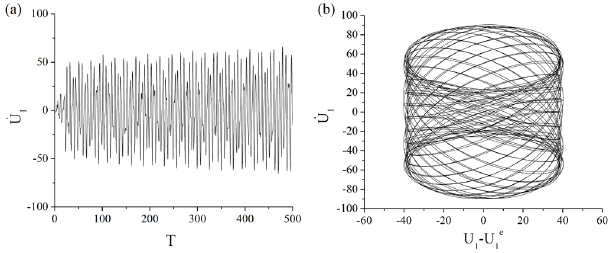
Fig. 5. Temporal evolution of variable ˙ U 1 (a) and corresponding phase portrait (b) for τ 1 = 4, τ 2 = 5 ,c 1 = c 2 = 2, k 1 = k 2 = k = 1 = ν c = 1 (quasiperiodic motion). and ν c 1 2